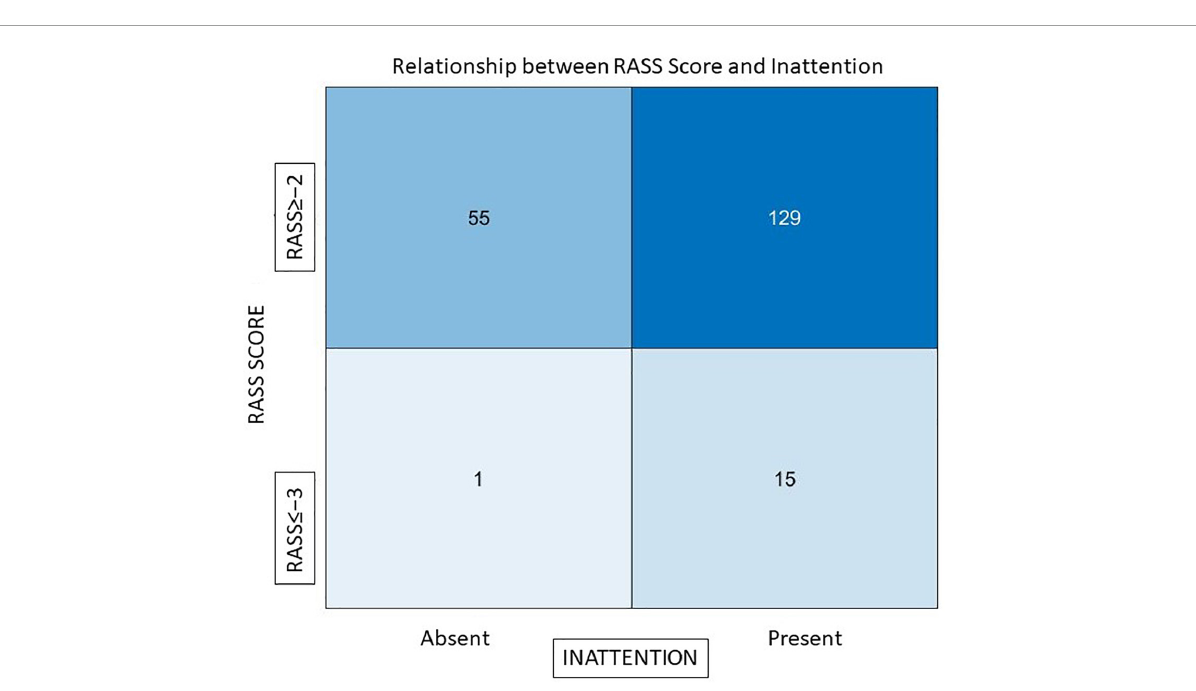
FIGURE2 The relationship between RASS scores and inattention. The x-axis represents those who had inattention and those who did not, y-axis represents RASS scores of patients Out of a total of 144 individuals who failed the attention tests 129 (89.5%) had an adequate level of arousal (RASS ≥ −